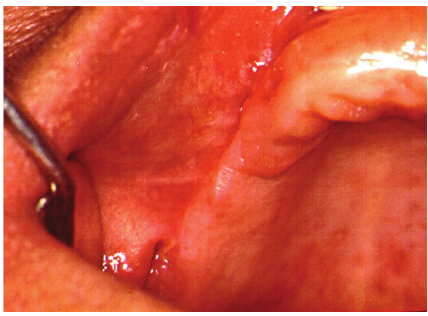
Figure 4: One-year follow-up photograph showing no local